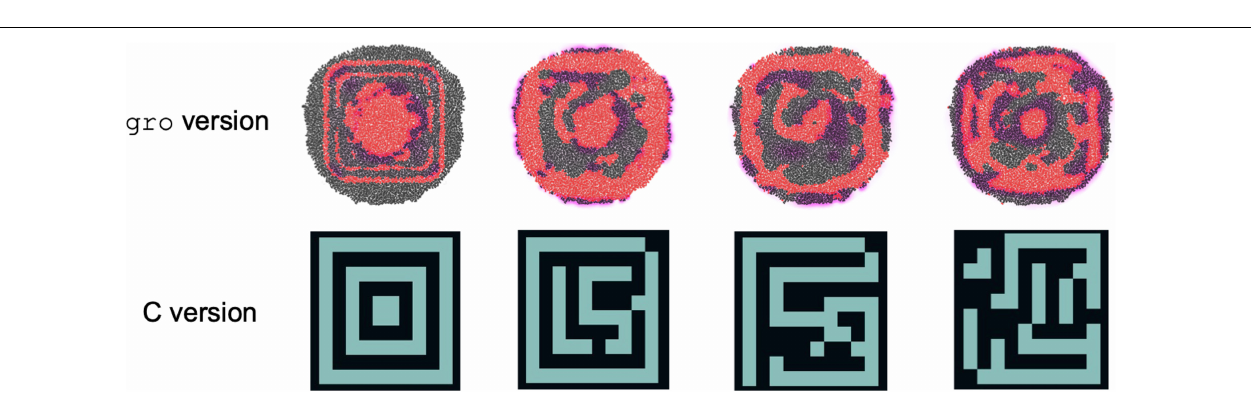
FIGURE 6 | Circuit implementation and simulation. (A) SGA circuit implementation and simulation. The set of plasmids required to be absent for the fitness function to be optimal are organized in an OR gate manner. If any protein of this set is present, it triggers the cI repressor which in turn represses the fitness reporting (GFP for this example). The plasmids required to be present are processed through an AND gate design: if any of these proteins are missing, the trpR repressor causes the final cI repressor to act on the GFP reporting. Proteins not included in this design are omitted from the fitness evaluation, which is equivalent to a “don’t care” classification in terms of fitness values. All plasmids encoding proteins for evaluation are conjugative. Please see Figure 3A caption for details on how the input plasmids, transduction circuits, and fitness evaluation circuit were designed. (B) The SA implementation follows a very similar design to the one made for SGA, however, it incorporates a temperature sensing module, in which aTc concentration regulates conjugation frequency, having higher conjugation rates when aTc concentration is higher, and gradually lower ones as aTc concentration diminishes. This occurs by negatively regulating the fundamental bacterial conjugation rel protein, with the tetR repressor, and cancelling the repression in high aTc concentration zones. (C) A Game of Life (CA) design is implemented in two parts. It should be noted that a CA does not use a fitness function, therefore does not include this part in the implementation. One of the modules initiates the system, since no AHL signals are present in the beginning (and represent the neighborhood signaling for a “live cell”). The system starts by subjecting the cells to an aTc zone to kickstart the production of AHL (by canceling the tetR repressor). Also, these starting cells are identified by a GFP marker. Once the system is started, the first module ceases its operation and the other module, an adaptation of a band detector (Basu et al., 2005), evaluates the Game of Life in a mid-range concentration of AHL (for assessing live cells maintaining their state or dead cells coming to life). This second module is the one that keeps the CA running afterward.